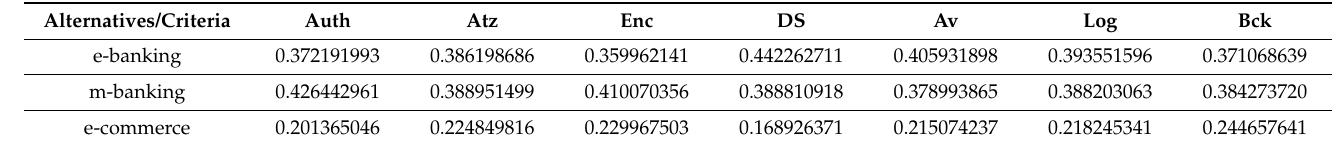
Table 9. Eigenvectors of inherent criteria for transaction systems.